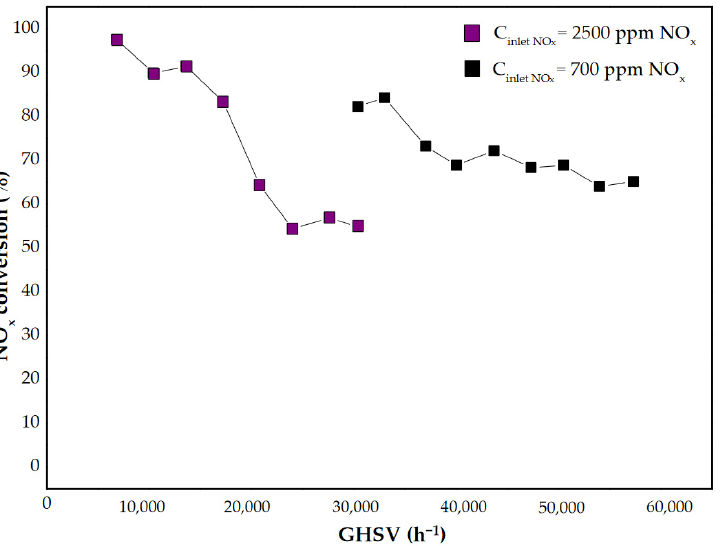
Figure 10. The results of NO x conversion as a function of GHSV for the shaped Fe-Clin-I catalyst sample at 450 °C.